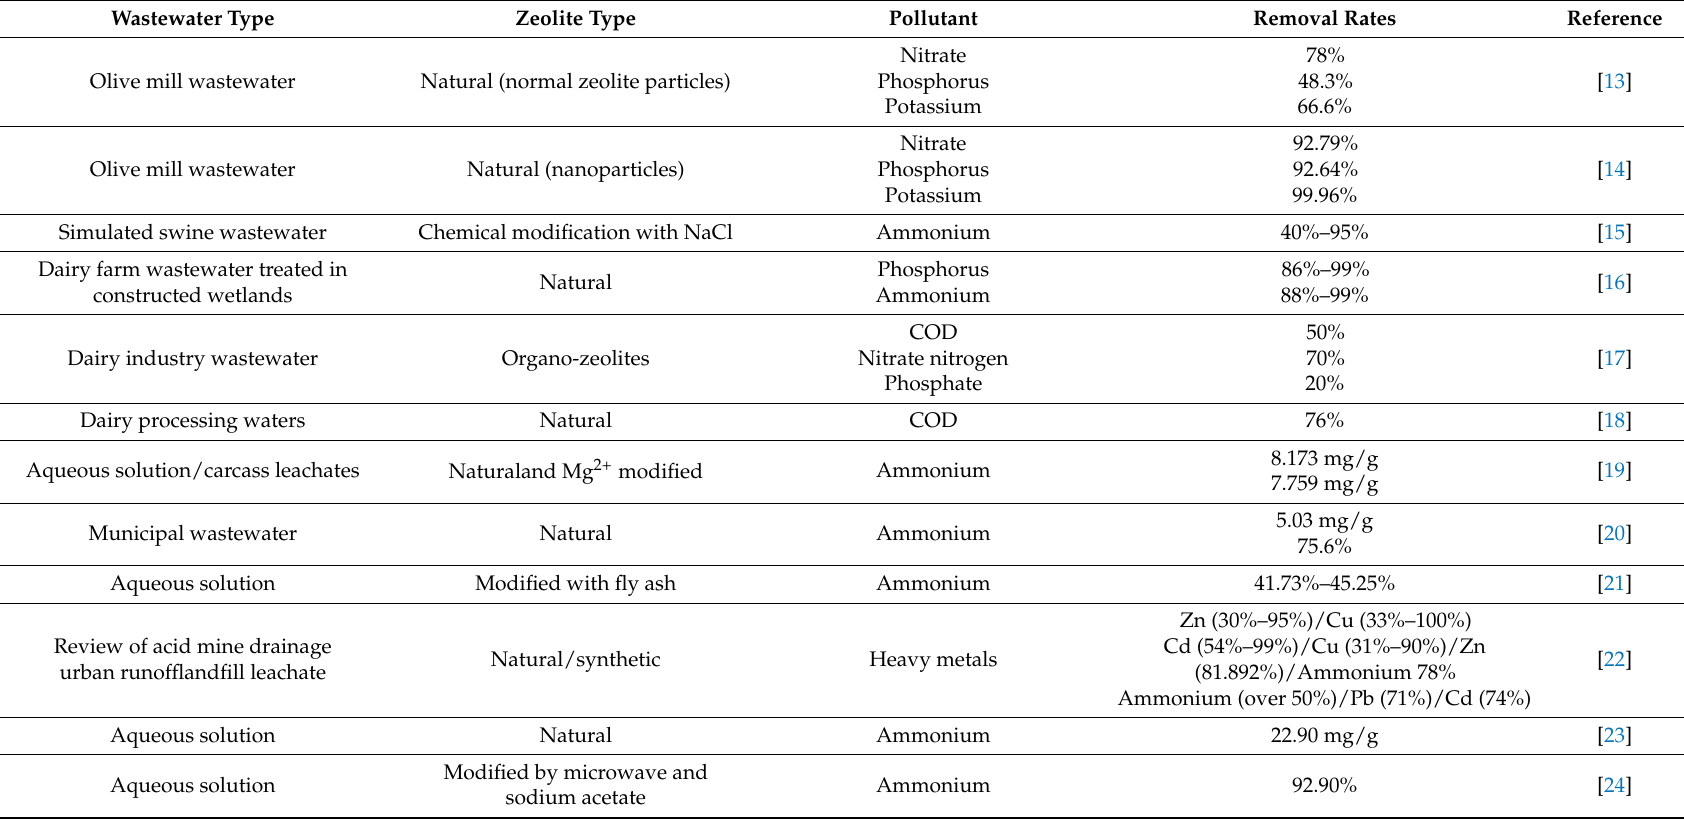
Table 1. Studies of zeolite use in wastewater